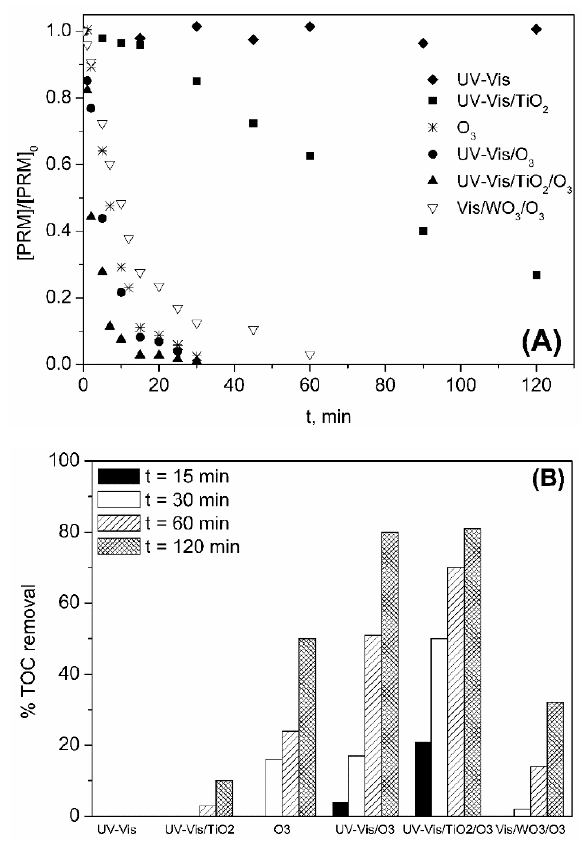
Figure 9. Variation with time of PRM normalized concentration ( A ) and percentage of TOC removed ( B ) during the application of different processes in SE wastewater. Experimental conditions (see also Table 1): [PRM] 0 = 5 mg L − 1 ; [TOC] 0-PRM 3.3 mg L − 1 ; [TOC] 0-SE = 11 mg L − 1 ; [TiO 2 ] = 0.25 g L − 1 ; [WO 3 ] = 0.25 g L − 1 ; pH 0 8.2; Q m,O3 = 3.3 mg min − 1 ; T = 20–37 ◦ C; I Vis = 7.75 × 10 − 5 Einstein L − 1 s − 1 ; I UV-Vis = 8.2 × 10 − 5 Einstein L − 1 s − 1 .